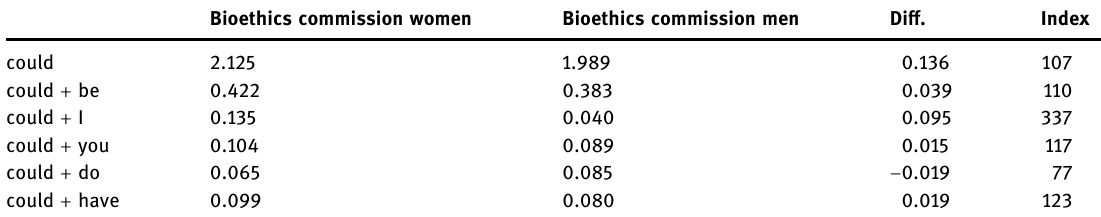
Table 21: Most frequent collocation with “ could, ” as per cent of total tokens ( normalised, n = 1,000